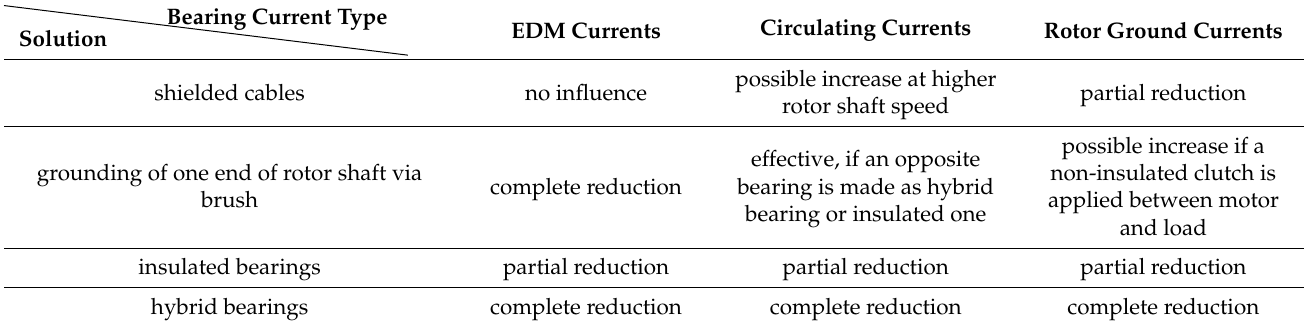
Table 1. Effectiveness of the most commonly applied solutions dedicated to bearing current reduction.